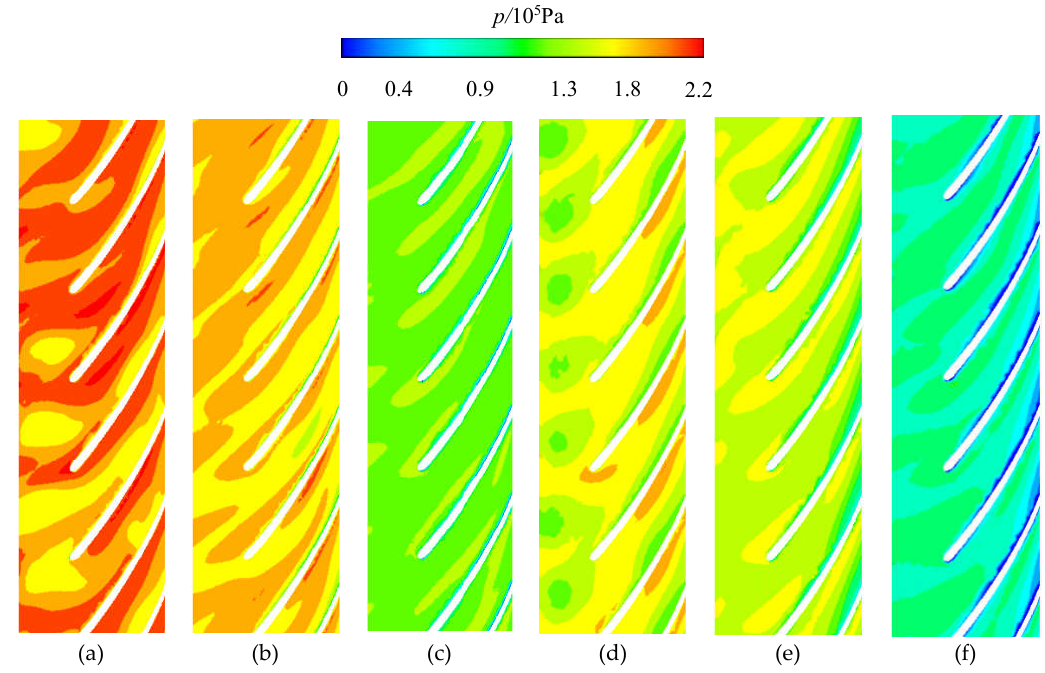
Figure 12. Pressure contour at second-stage impeller outlet, ( a ) 0.3 mm, ( b ) 0. 6mm, ( c ) 0.9 mm, ( d ) 1.2 mm.